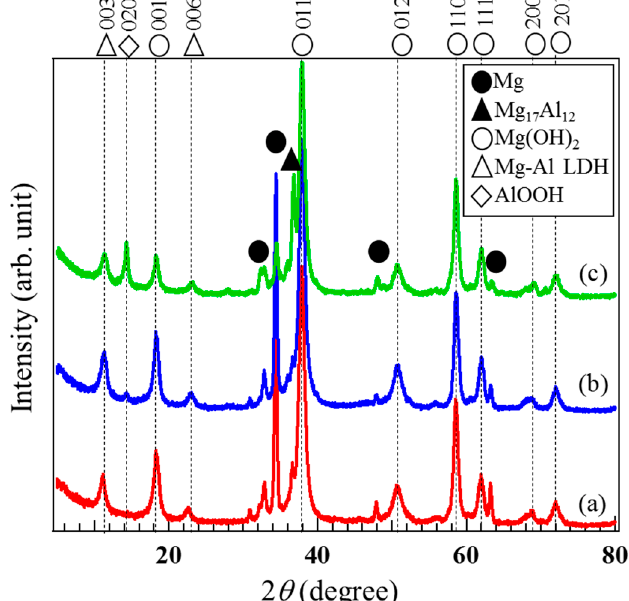
Figure 3. XRD patterns of the films prepared at 423 K for 5 h on each Mg alloy: (a) AZ31, (b) AZ61, and (c) AZ91D.